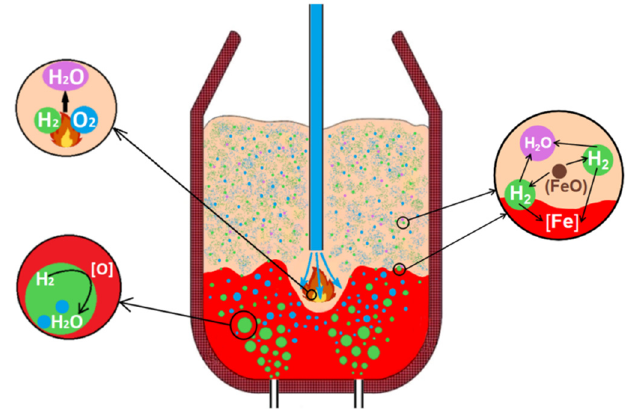
Figure 1. Metallurgical behaviors of hydrogen in converter.